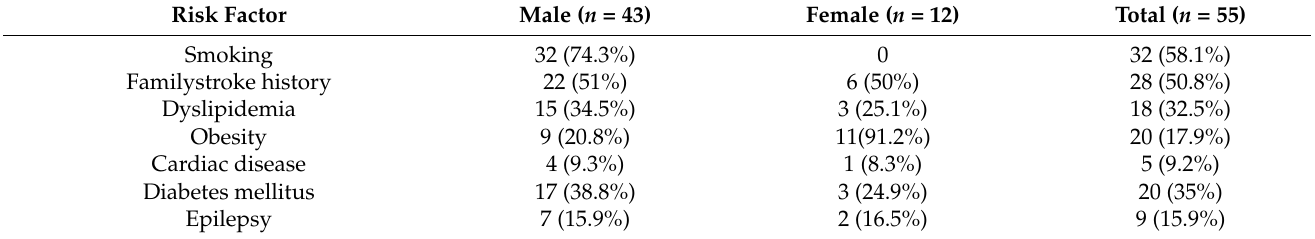
Table 3. Data were taken from different studies conducted in different countries to assess the prevalence of the risk factors of stroke